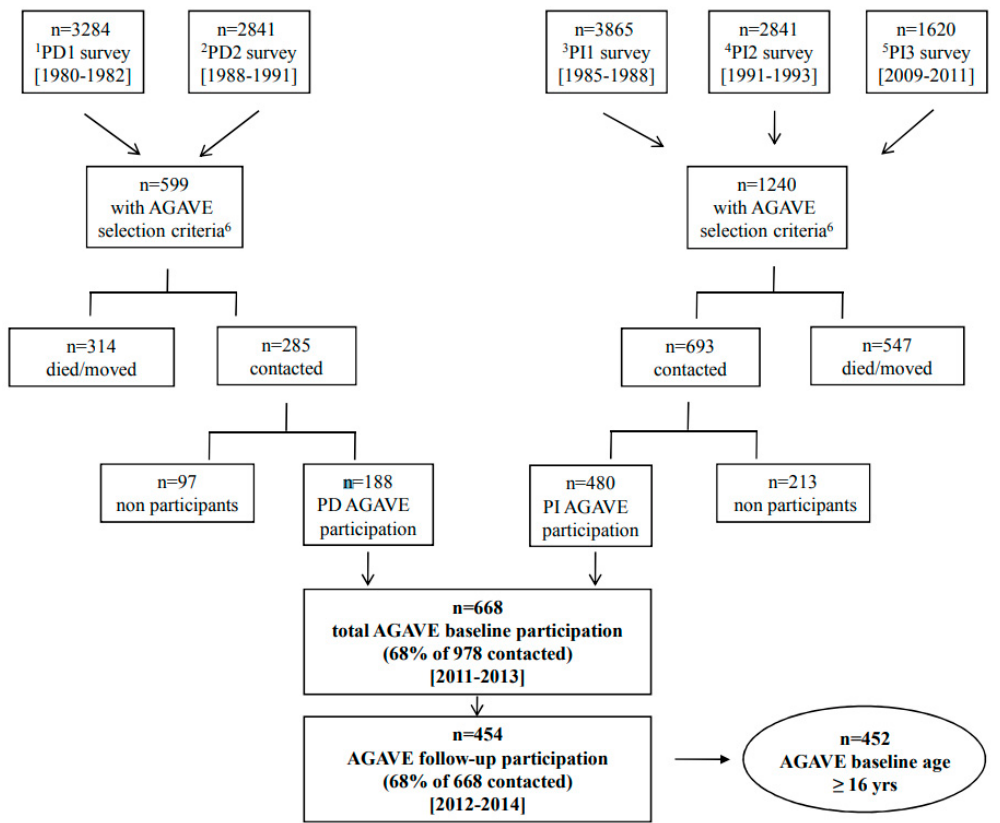
Figure 1. Flow-chart of subjects participation. 1 PD1, Po Delta first survey; 2 PD2, Po Delta second survey; 3 PI1, Pisa first survey; 4 PI2, Pisa second survey; 5 PI3, Pisa third survey; 6 AGAVE selection criteria: subjects reporting asthma diagnosis or asthma symptoms (asthma attacks or wheezing) in at least one of the previous epidemiological surveys.